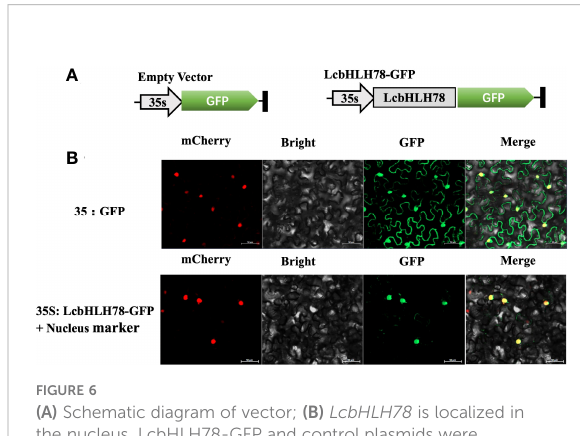
FIGURE 6 (A) Schematic diagram of vector; (B) LcbHLH78 is localized in the nucleus. LcbHLH78-GFP and control plasmids were transiently expressed in N. benthamiana cells. Fluorescence was observed using a confocal fl uorescence microscope at 36 h after incubation. Pictures show mCherry, bright, GFP, and Merge from left to right. Bar = 50 m